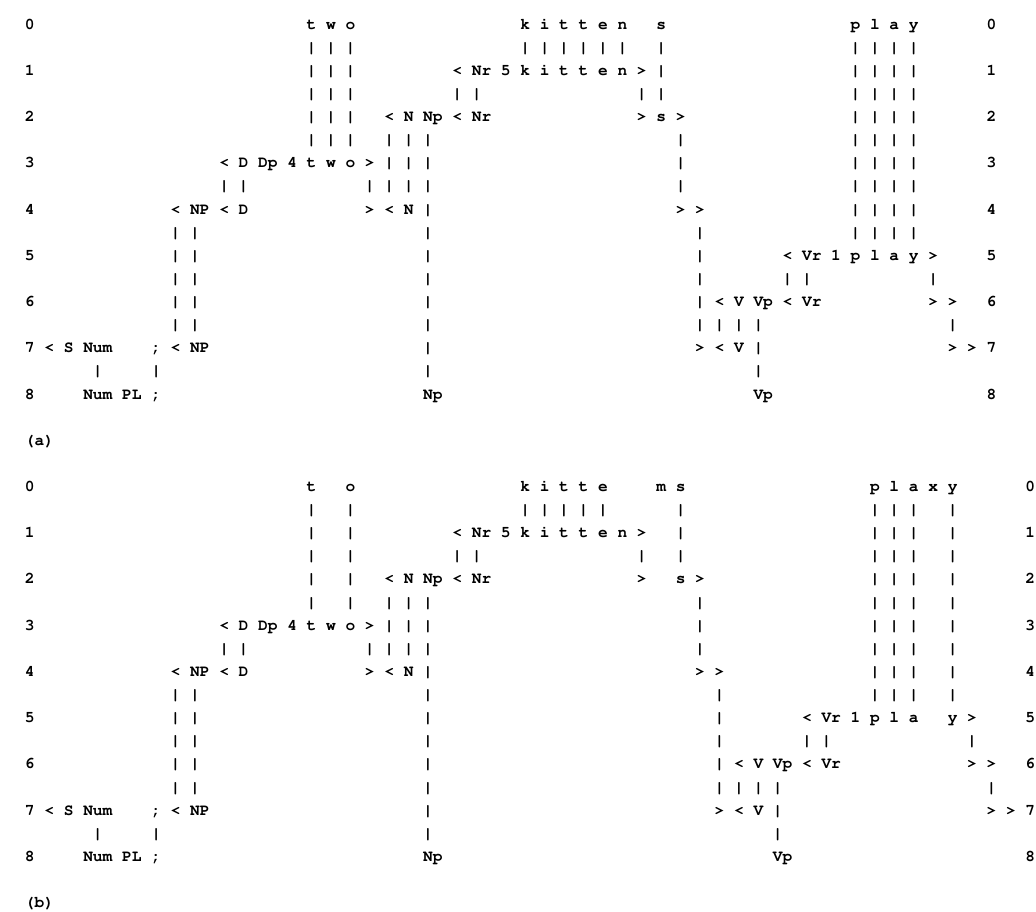
Figure 6. ( a ) The best multiple alignment created by the SP model with a store of Old patterns, like those in rows 1 to 8 (representing grammatical structures, including words) and a New pattern (representing a sentence to be parsed) shown in row 0; ( b ) as in (a), but with errors of omission, commission and substitution, and with the same set of Old patterns as before. (a) and (b) are reproduced from Figures 1 and 2 in [35], with